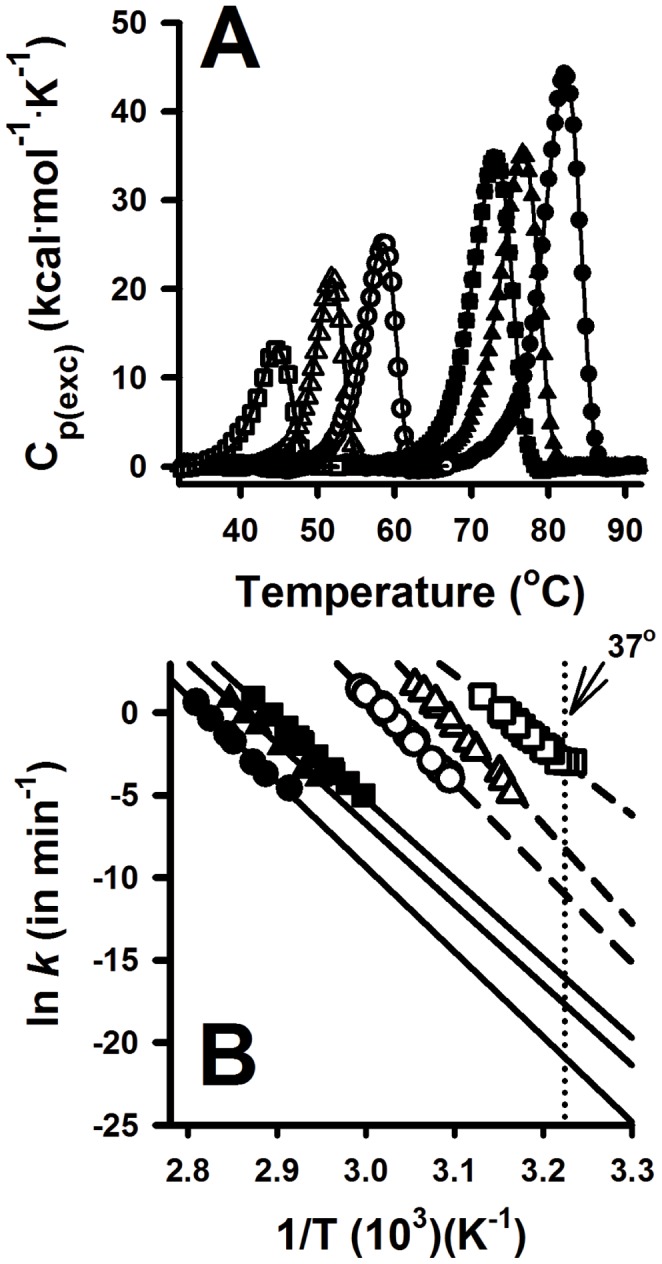
Thermal denaturation of AGT variants studied by differential scanning calorimetry (DSC).A) Representative DSC traces obtained at 3°C/min; Lines are best-fits from a two-state irreversible denaturation model with first-order kinetics [6]; B) Arrhenius plots for the irreversible denaturation of AGT variants, indicating also the extrapolated rate constants at physiological temperature (intercept with the vertical dotted line). Symbols are: WT (circle), LM (triangle) and p.F152I (square). Data for holo proteins are shown as closed symbols and for apo proteins as open symbols.